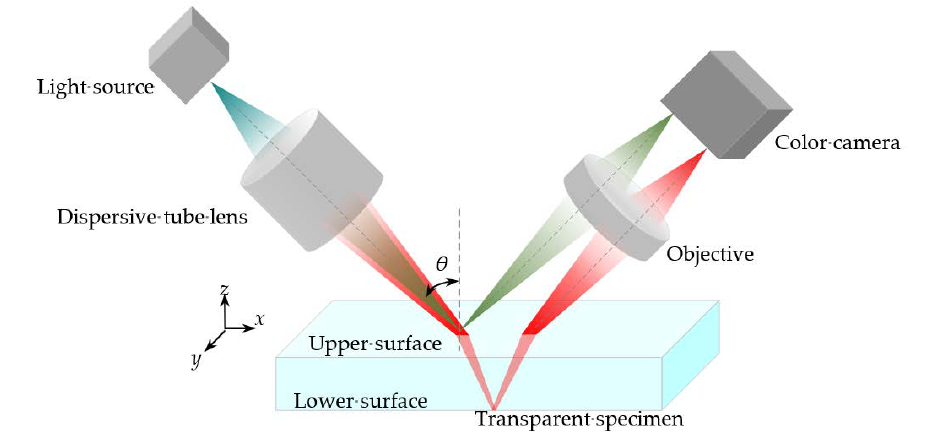
Figure 3. Separation of these two signals from the upper and lower surfaces of a transparent specimen ( θ is the inclined angle between the optical axis of incident light and the normal direction of the specimen surface).